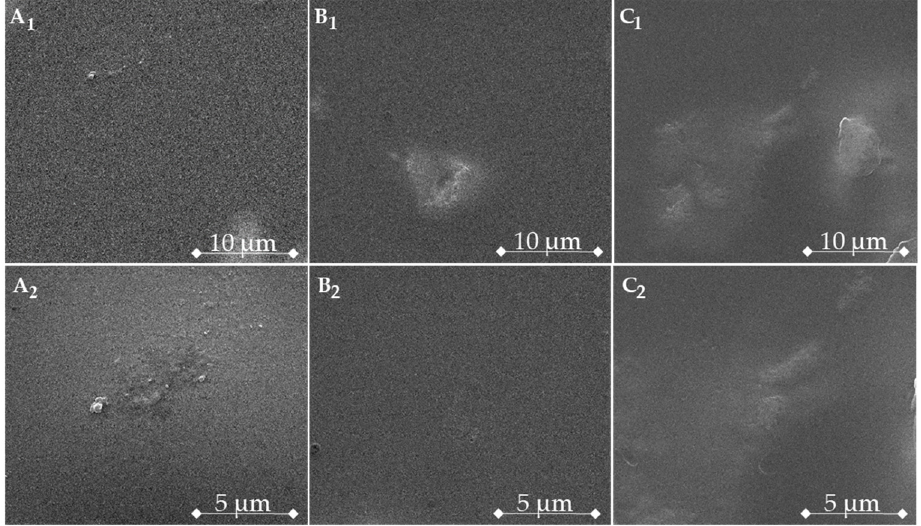
Figure 4. Cont. Figure 4.